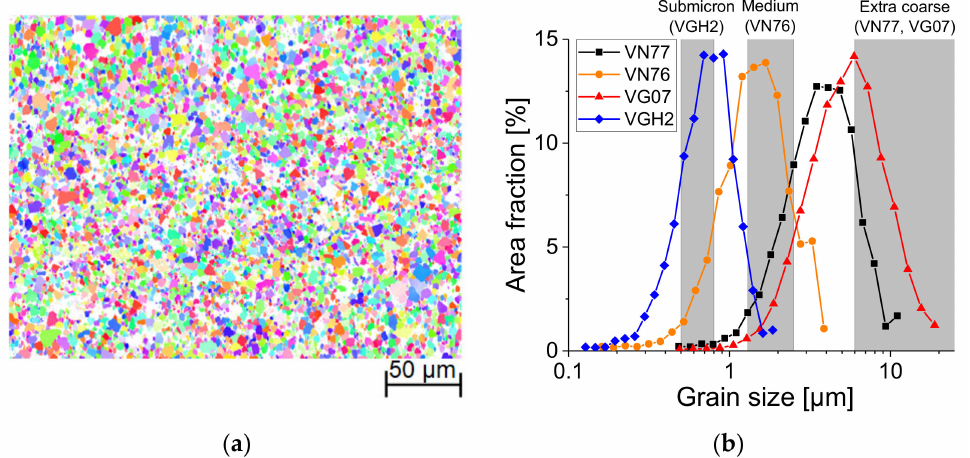
Figure 2. ( a ) An EBSD image of cemented carbide grades in inverse pole figure (IPF) representation, with VN77 as an example, and ( b ) the area fraction as a function of grain size of the four cemented carbide grades.